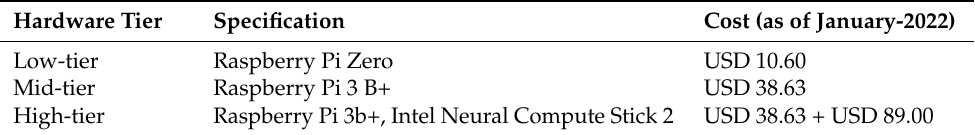
Table 3. Hardware tier details.